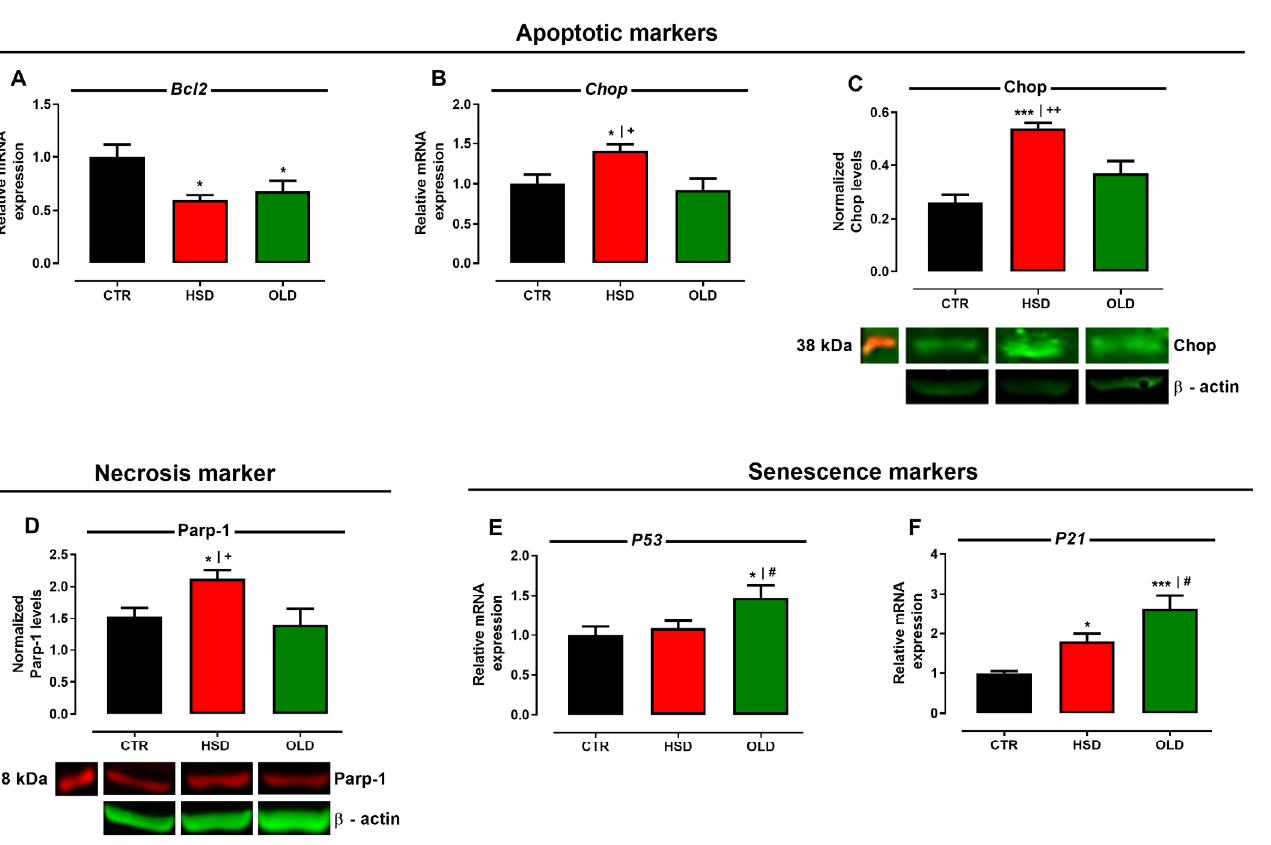
Figure 6. Expression of cell death and senescence markers in the hippocampus. Relative mRNA expression of the anti-apoptotic marker Bcl2 ( A ), gene expression ( B ), and protein levels ( C ) of the pro-apoptotic marker Chop; Calpain presence inferred by PARP-1 protein levels ( D ), relative mRNA expression of senescence markers p53 ( E ) and p21 ( F ) assessed in the hippocampi of rats fed a standard chow (CTR, n = 5) and a high-sucrose diet (HSD, n = 5) until 6 months from weaning, and middle-aged (20 months old) animals fed a standard chow (OLD, n = 5). Gene expressions were normalized to the relative levels of GAPDH, the results are expressed as the fold change values of 2 −ΔΔ CT , and protein levels are expressed as relative density normalized by anti- β -Actin. Bars represent the mean ± SEM (one-way ANOVA Newman–Keuls). * p < 0.05, *** p < 0.001 when compared to CTR, + p < 0.05, ++ p < 0.01 when compared to OLD, and # p < 0.05 when compared to HSD.